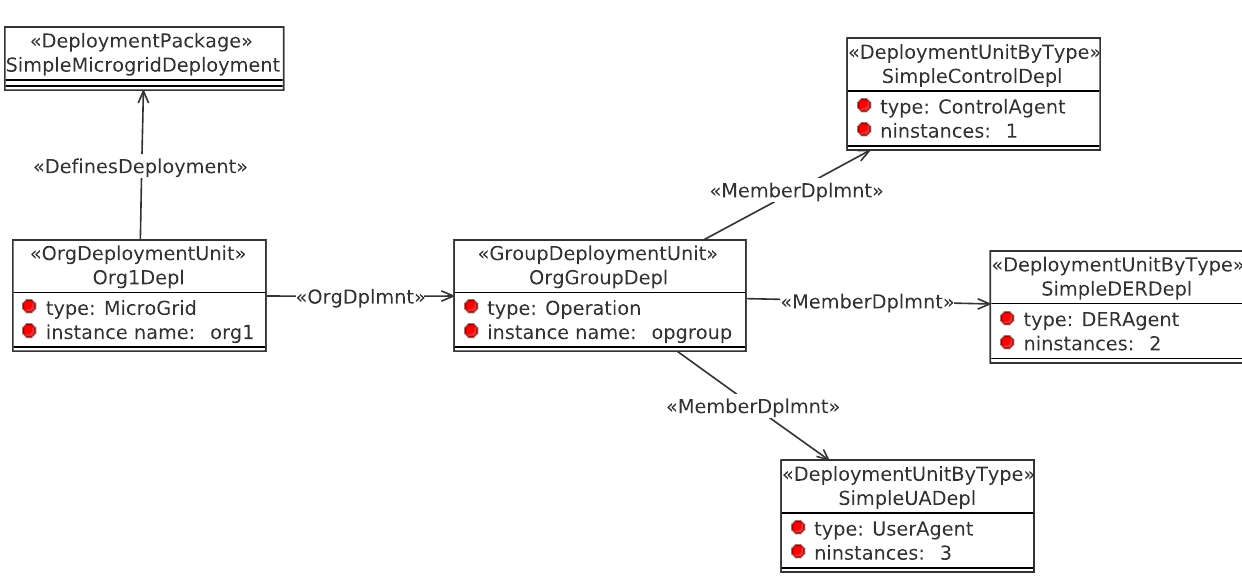
Figure 6. Initial deployment description of the system.